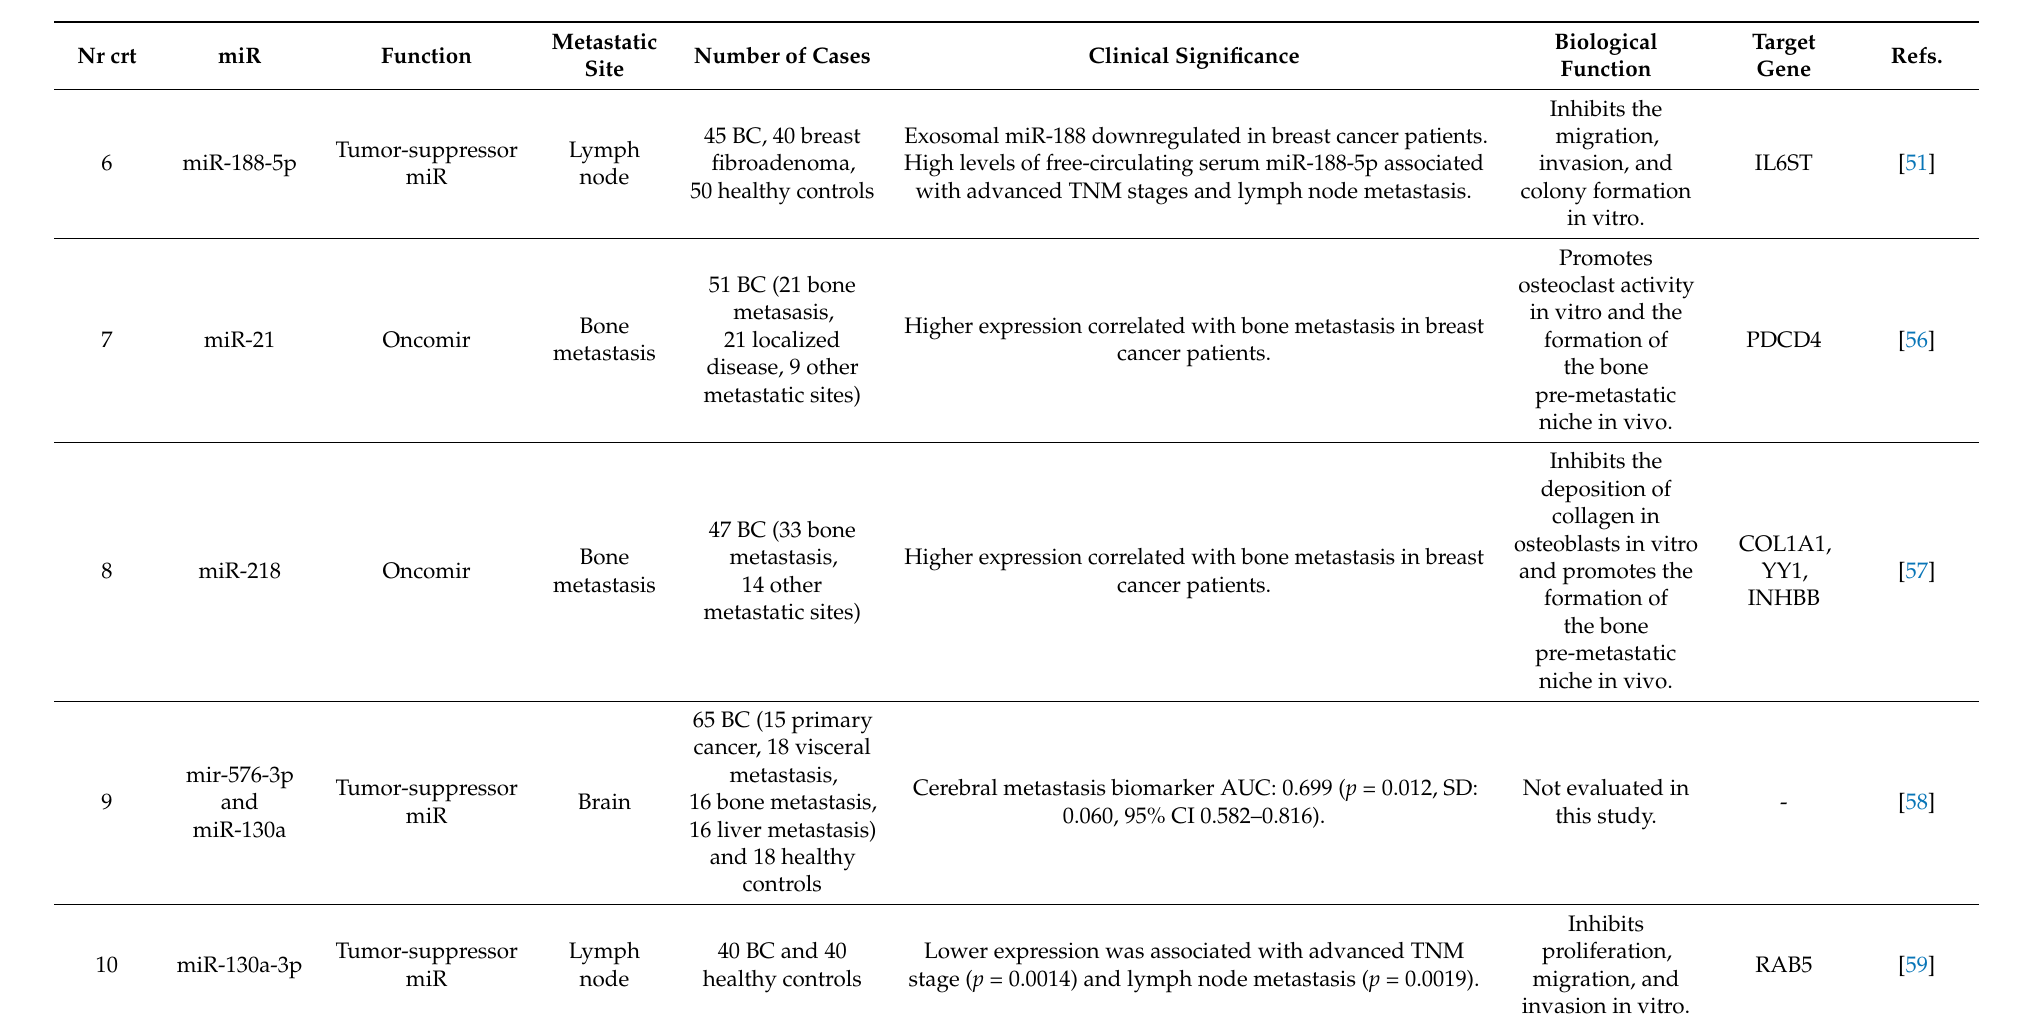
with advanced TNM stages and lymph node metastasis.